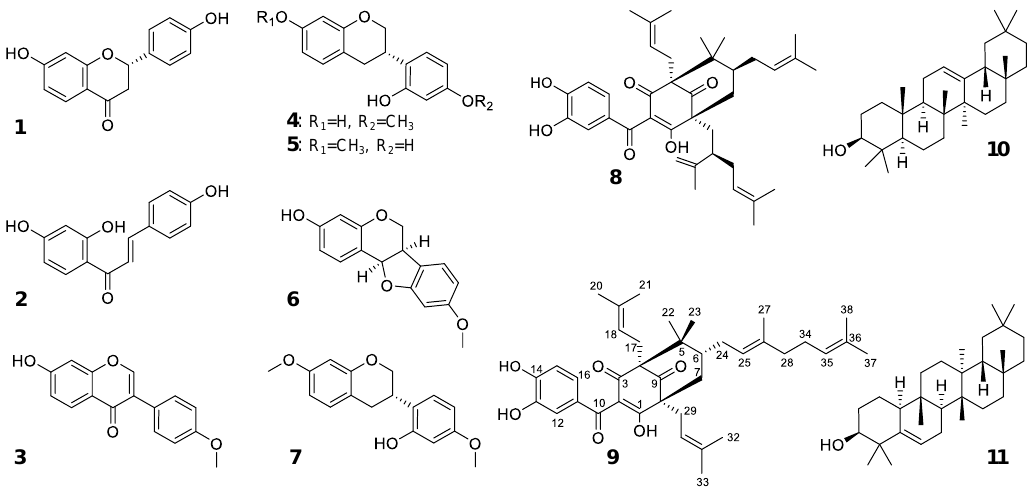
Figure 1. Chemical constituents of Brazilian red propolis.